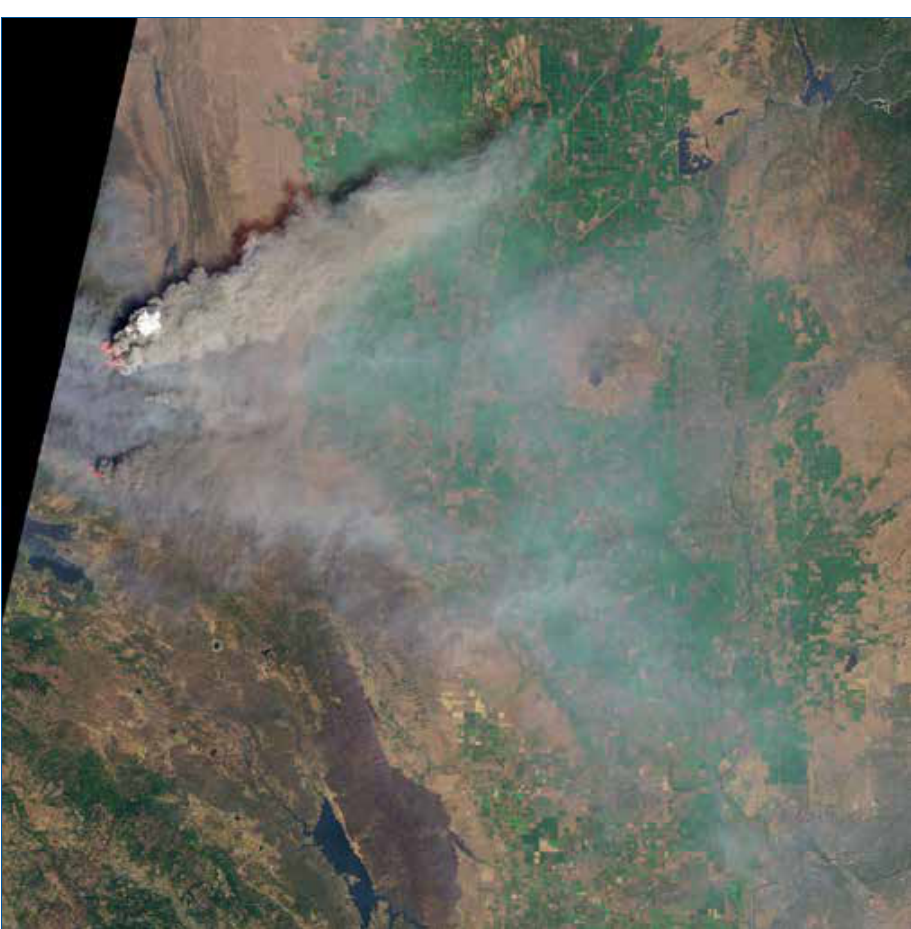
Figure 1. Composite image from the west coast of the United States in July 2018. One of the wildfires, the Mendocino Complex, became the largest fire on record in California. As of August 7, 2018 (when the fire was still burning), it had burned 1,200 km 2 . Source: https://www.nasa.gov/mission_pages/